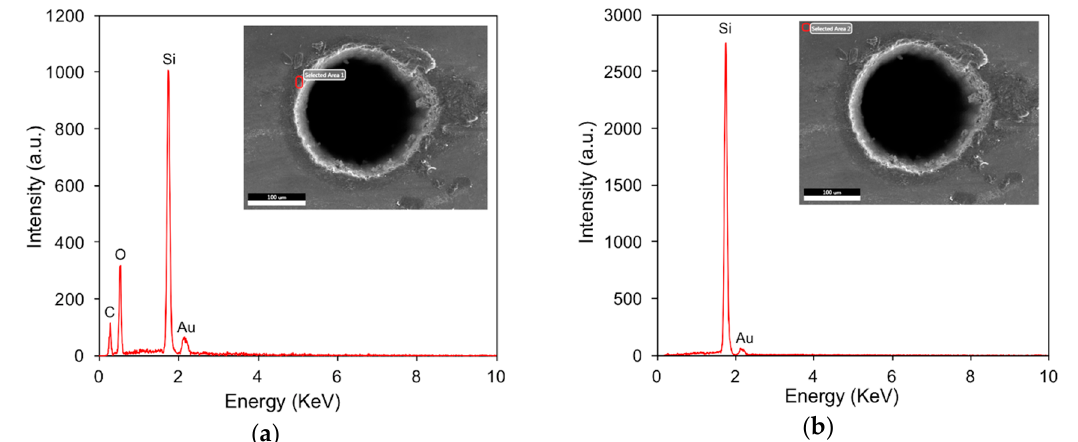
Figure 10. EDS spectra comparison at ( a ) hole edge and ( b ) non-ablated position. The red square in the upper-right figure represents the examined position. The process parameters include: P = 32 W, f = 0.4 MHz, v = 1200 mm/s, n = 15, and m = 100. f = 0.4 MHz, v = 1200 mm/s, n = 15, and m = 100.